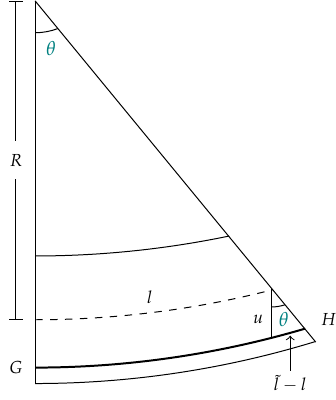
Figure 3. The elongation of the